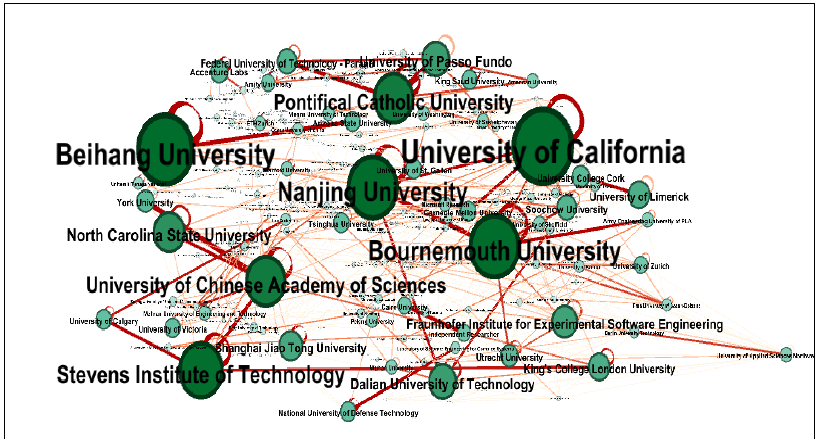
Figure 6. Institutional co-authorship network. Table 10. Institutions involved most frequently in co-authorships.